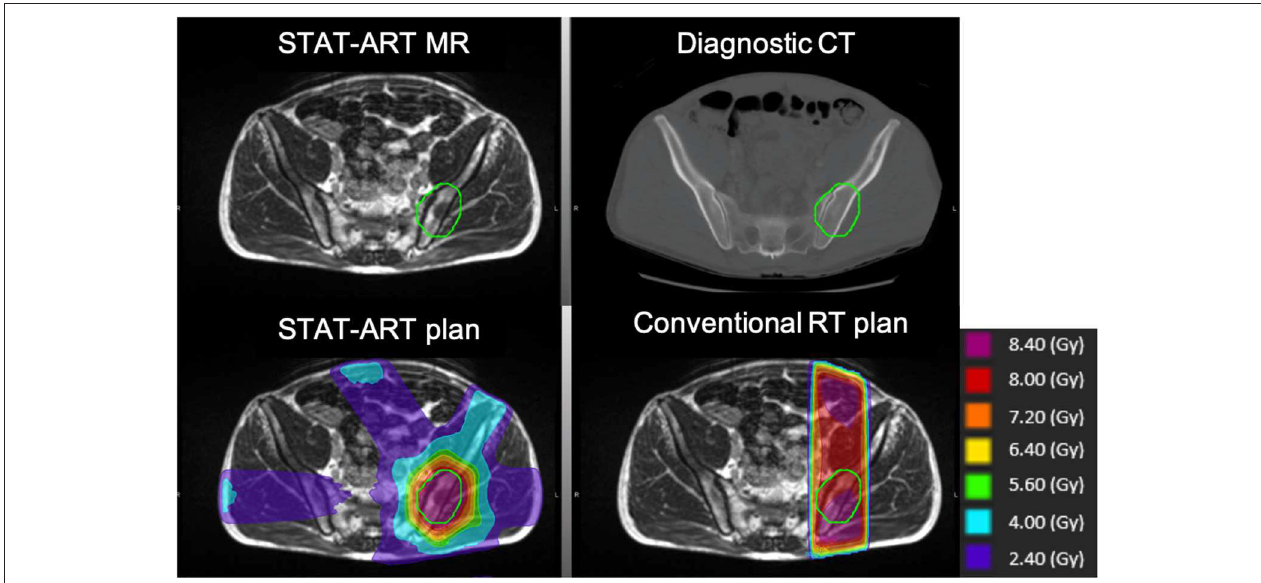
FIGURE 2 | Clinical STAT-ART case of a pelvic bony metastasis treated to 8Gy in a single fraction to the planning target volume in green. Comparison of diagnostic CT used for pre-planning (top right) and improved gross disease visualization on the TrueFISP treatment planning MR obtained using the MRIdian (top left). The resulting dose distribution for STAT-ART plan of a six-beam cobalt-60 dose distribution (bottom left) in comparison to a conventional plan with 10MV AP/PA beams (bottom right). The STAT-ART plan shows a marked reduction of the high dose volume, particularly in anterior regions of normal tissues.